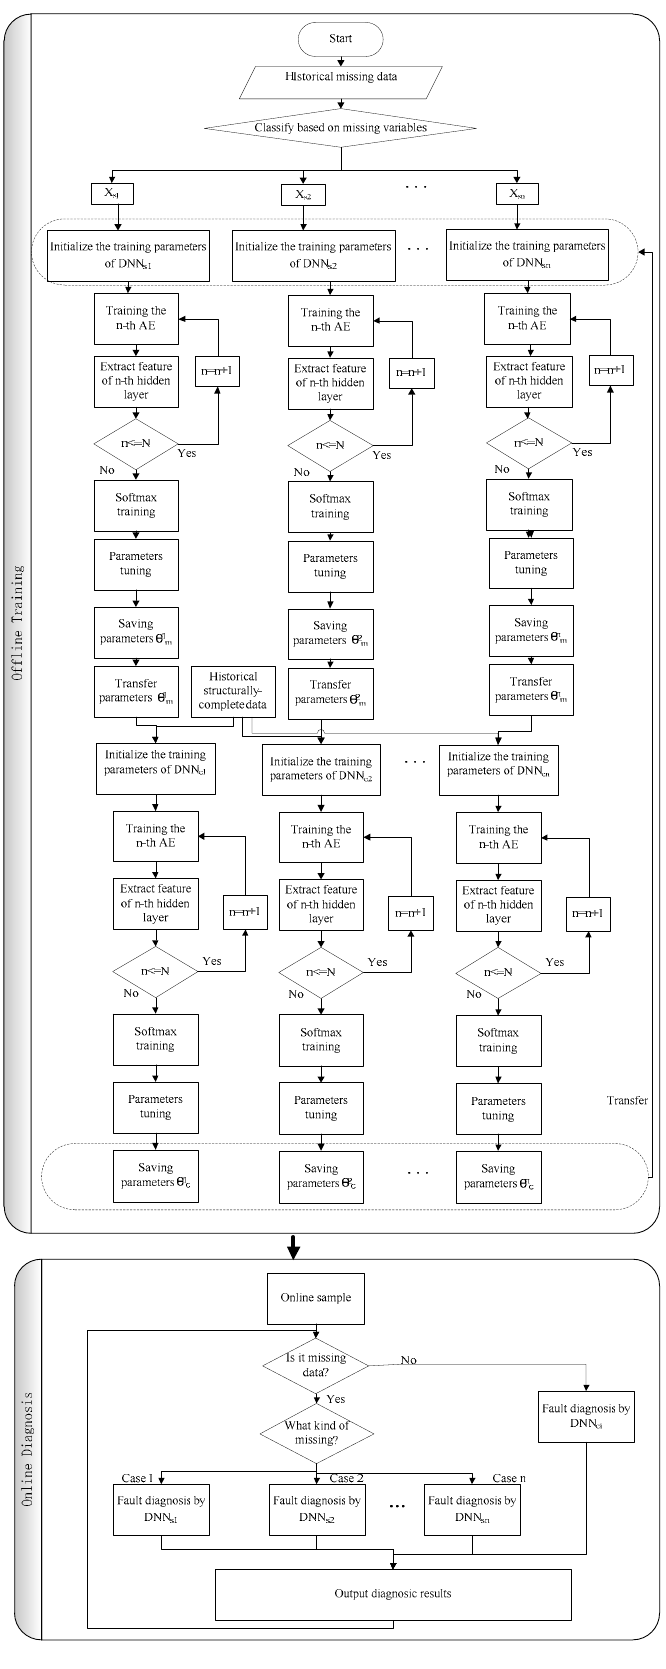
Figure 4. Fault diagnosis flowchart with missing data based on transfer learning.